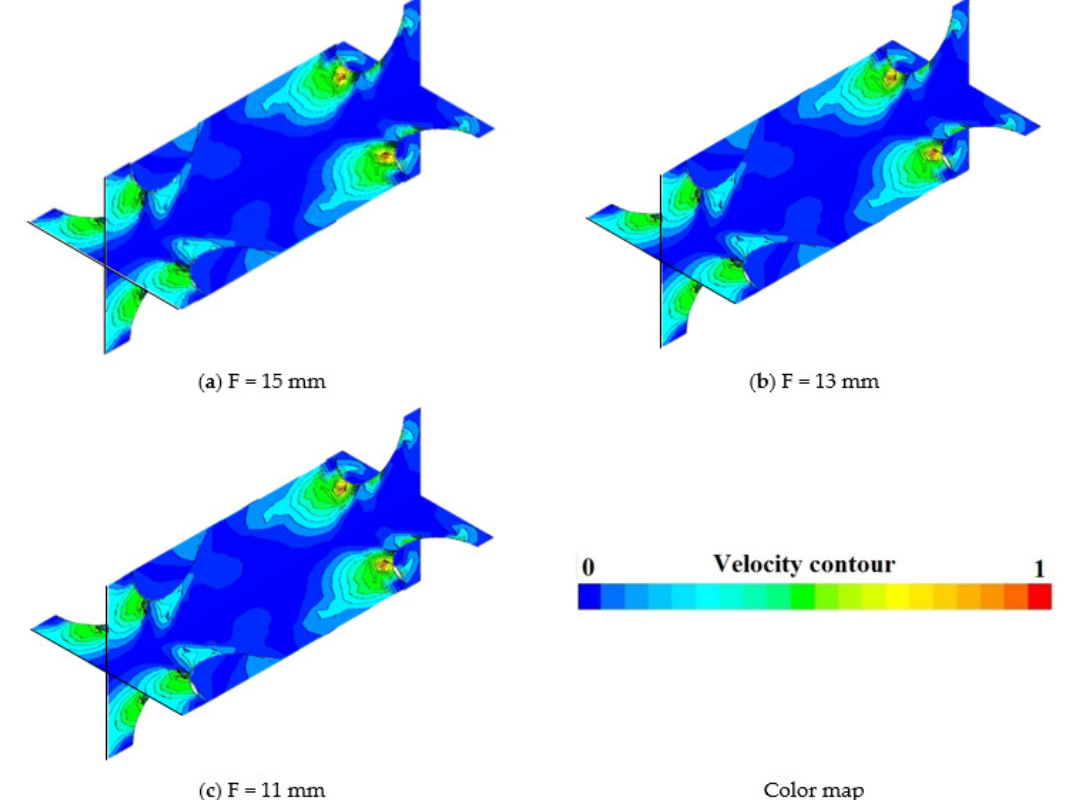
Figure 31. Velocity magnitude contours for various configurations of Case F with different F parameters at Re = 15,000, and ϕ =